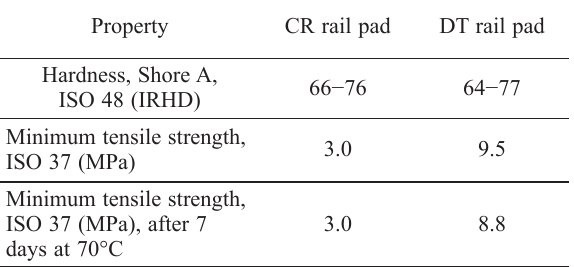
Table 1. Mechanical properties of deconstructed tire (DT) rail pads and commercial crumb rubber (CR) rail